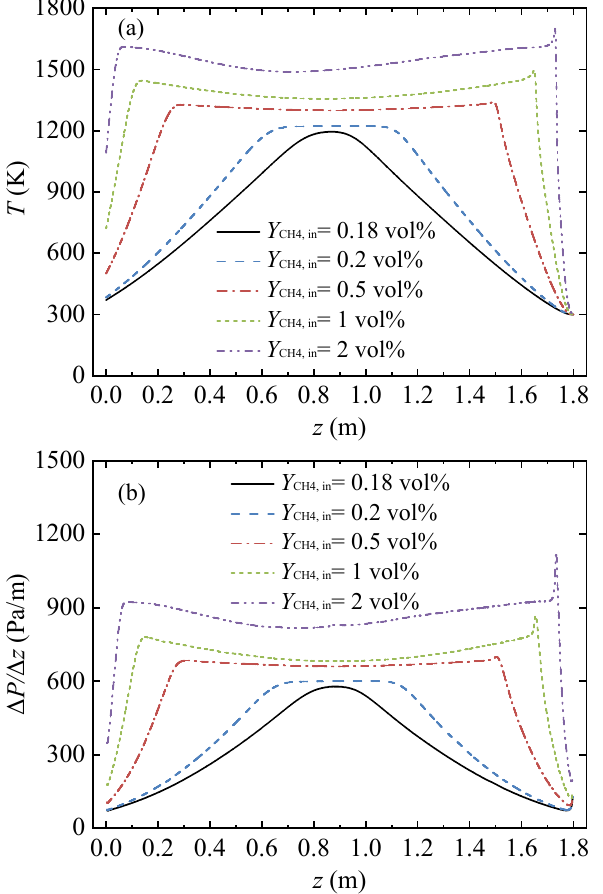
Figure 3. Gas temperature and pressure gradient profiles along the arial direction in the conduit, with various feed methane volume fractions. ( a ) Gas temperature profiles and ( b ) pressure gradient profiles.